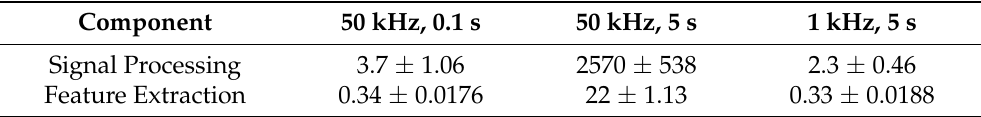
Table 5. The table shows the latencies of the signal processing pipelines for optimised configurations of all the experiments. We separately report the feature extraction and the signal processing times. The tests are performed on the dataset fold 0, as the case with potentially longest evaluation times. The times are reported in seconds as mean and standard deviation over 100 pipeline